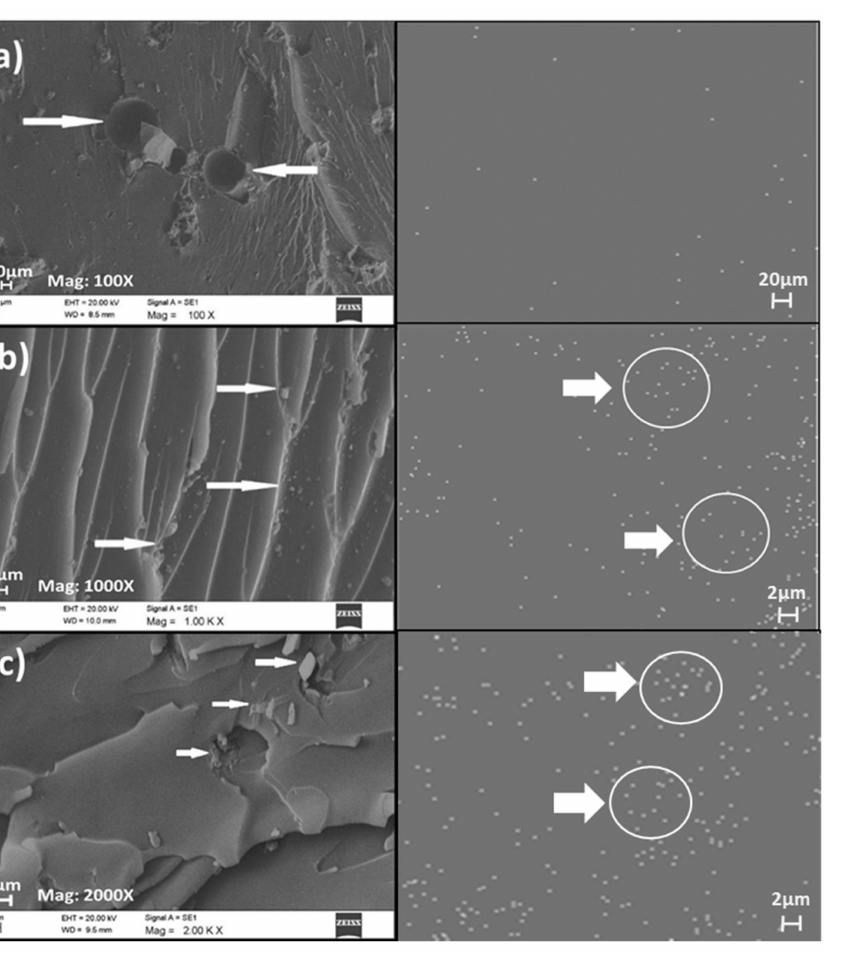
Figure 9. FESEM micrograph and elemental distribution mapping of ( a ) neat PF resin, ( b ) PF nanocomposite-filled 1% OPB nanoparticles, and ( c ) PF nanocomposite-filled 2% OPB